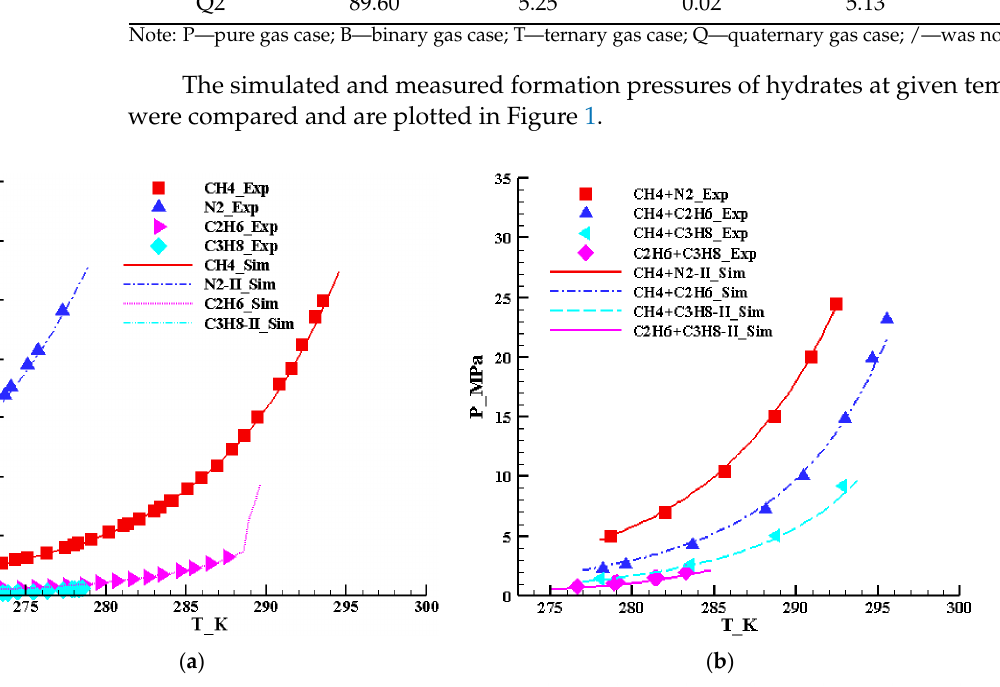
( d ) Figure 1. Simulated and measured formation pressures of hydrates in cases with various gas combinations. ( a ) Pure gas cases; ( b ) binary gases cases; ( c ) ternary gases cases; ( d ) quaternary gases cases. Figure 1 shows that for both pure-gas cases and for mixed-gas cases, the predicted formation pressures of hydrates at given temperatures using the developed simulator (solid lines with di ff erent colors) were in good agreement with the measured data (indicated by varying symbols). The AARD of all case simulations were calculated using Equation (23) and are listed in Table 5. Analyzing the calculated AARD showed that all AARD values obtained in the thirteen case simulations were below 5.0%. The case simulation of Q1 yielded the maximum AARD of 4.94%, and the case simulation of B4 gave the minimum AARD of 0.65%. The AARD derived from the pure, binary and ternary gas cases were lower than those from the quaternary cases.